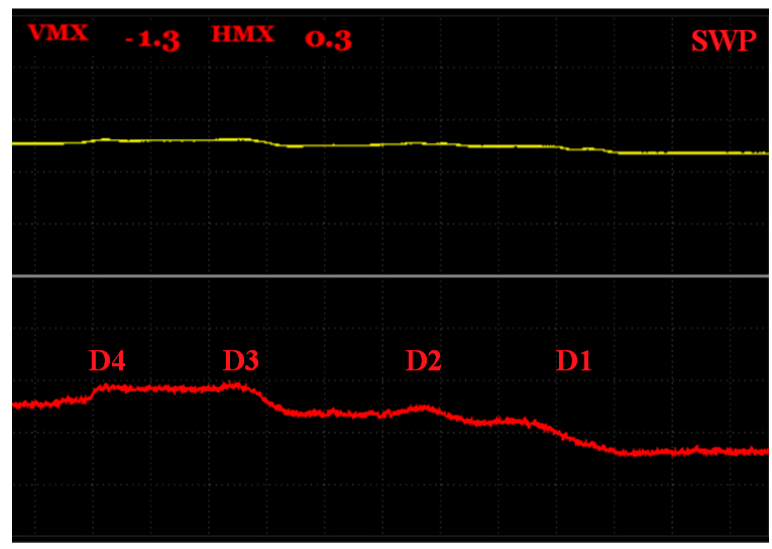
Figure 20. S6 sample, signal-to-depth of defect variation at 25 kHz excitation frequency. Additionally, D6 defects in the signal variations in the S2, S3, S3 (reversed) and S5 samples at the same frequency (10 kHz) were compared for the SWEEP regime in the same way as the IMPEDANCE regime (Figure 21).